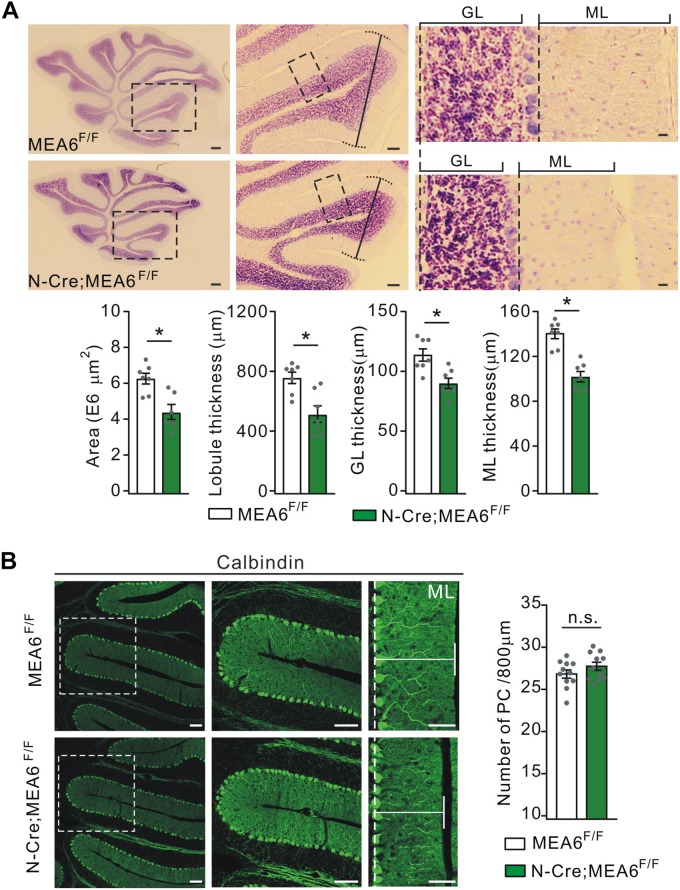
Shrunken lobules in N-Cre;MEA6F/F mice. (A) The H&E staining of sagittal cerebellar sections from MEA6F/F and N-Cre;MEA6F/F mice at P25. The middle panel (Scale bars: 100 μm) is the higher magnification of left panel (Scale bars: 200 μm) and the right panel (Scale bars: 10 μm) is the higher magnification of middle panel, as indicated by black dashed boxes. Cerebellar area: 6.3 ± 0.4 E6 μm2 (MEA6F/F; n = 7 mice) and 4.5 ± 0.7 E6 μm2 (N-Cre;MEA6F/F; n = 6 mice), unpaired t-test, *p < 0.05. Lobule III thickness: 758 ± 58 μm (MEA6F/F; n = 7 mice) and 518 ± 71 μm (N-Cre;MEA6F/F; n = 7 mice), unpaired t-test, *p < 0.05. Thickness of granule cell layer (GL; lobule III): 110 ± 5 μm (MEA6F/F; n = 7 mice) and 90 ± 4 μm (N-Cre;MEA6F/F; n = 7 mice), unpaired t-test, *p < 0.05. Thickness of molecular layer (ML; lobule III): 141 ± 4 μm (MEA6F/F; n = 7 mice) and 101 ± 4 μm (N-Cre;MEA6F/F; n = 7 mice), unpaired t-test, *p < 0.05. Gray dots indicate individual data points. (B) The calbindin staining in MEA6F/F and N-Cre;MEA6F/F mice (P25), indicating that the number and arrangement of PCs are not changed by the deletion of MEA6. Average numbers of PCs per 800 μm were 26.8 ± 0.5 (MEA6F/F; n = 11 mice) or 27.7 ± 0.5 (N-Cre;MEA6F/F; n = 11 mice). Gray dots indicate individual data points. Unpaired t-test, p > 0.05 (n.s.).